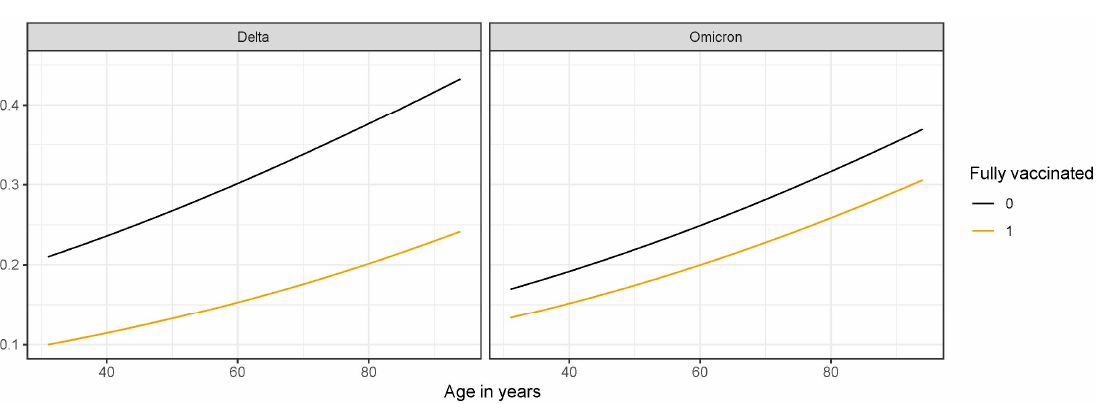
Figure 2. Modeled probability of progression to critically severe disease during the Delta and Omicron periods by vaccination status (vaccinated vs. unvaccinated) and age in years, as assessed from logistic regression model for two male patients with COVID-19, Charlson comorbidity index 4, and without immunocompromising conditions.